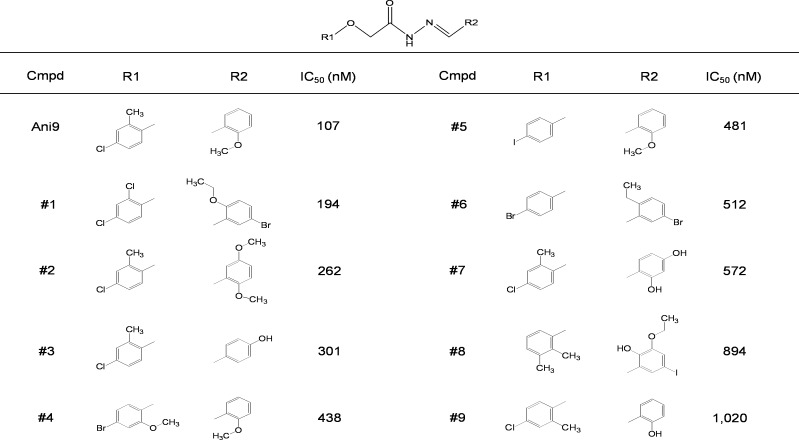
ANO1 inhibition by analogs of Ani9.Structure-activity analysis of Ani9 analogs. IC50 values were determined from fluorescence plate reader assay.